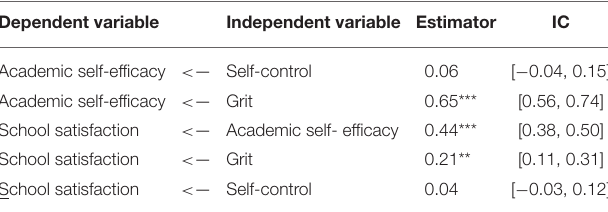
TABLE 5 | Indirect effects of the structural equation model for secondary